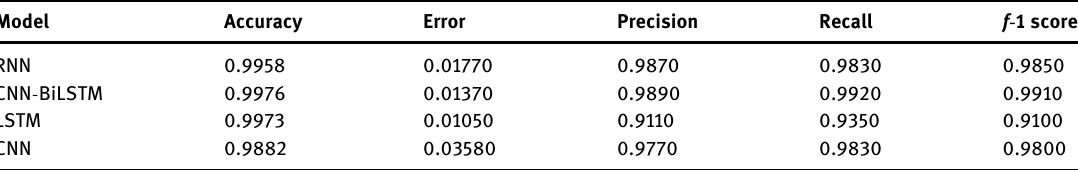
Table 4: The classi fi ers ’ results